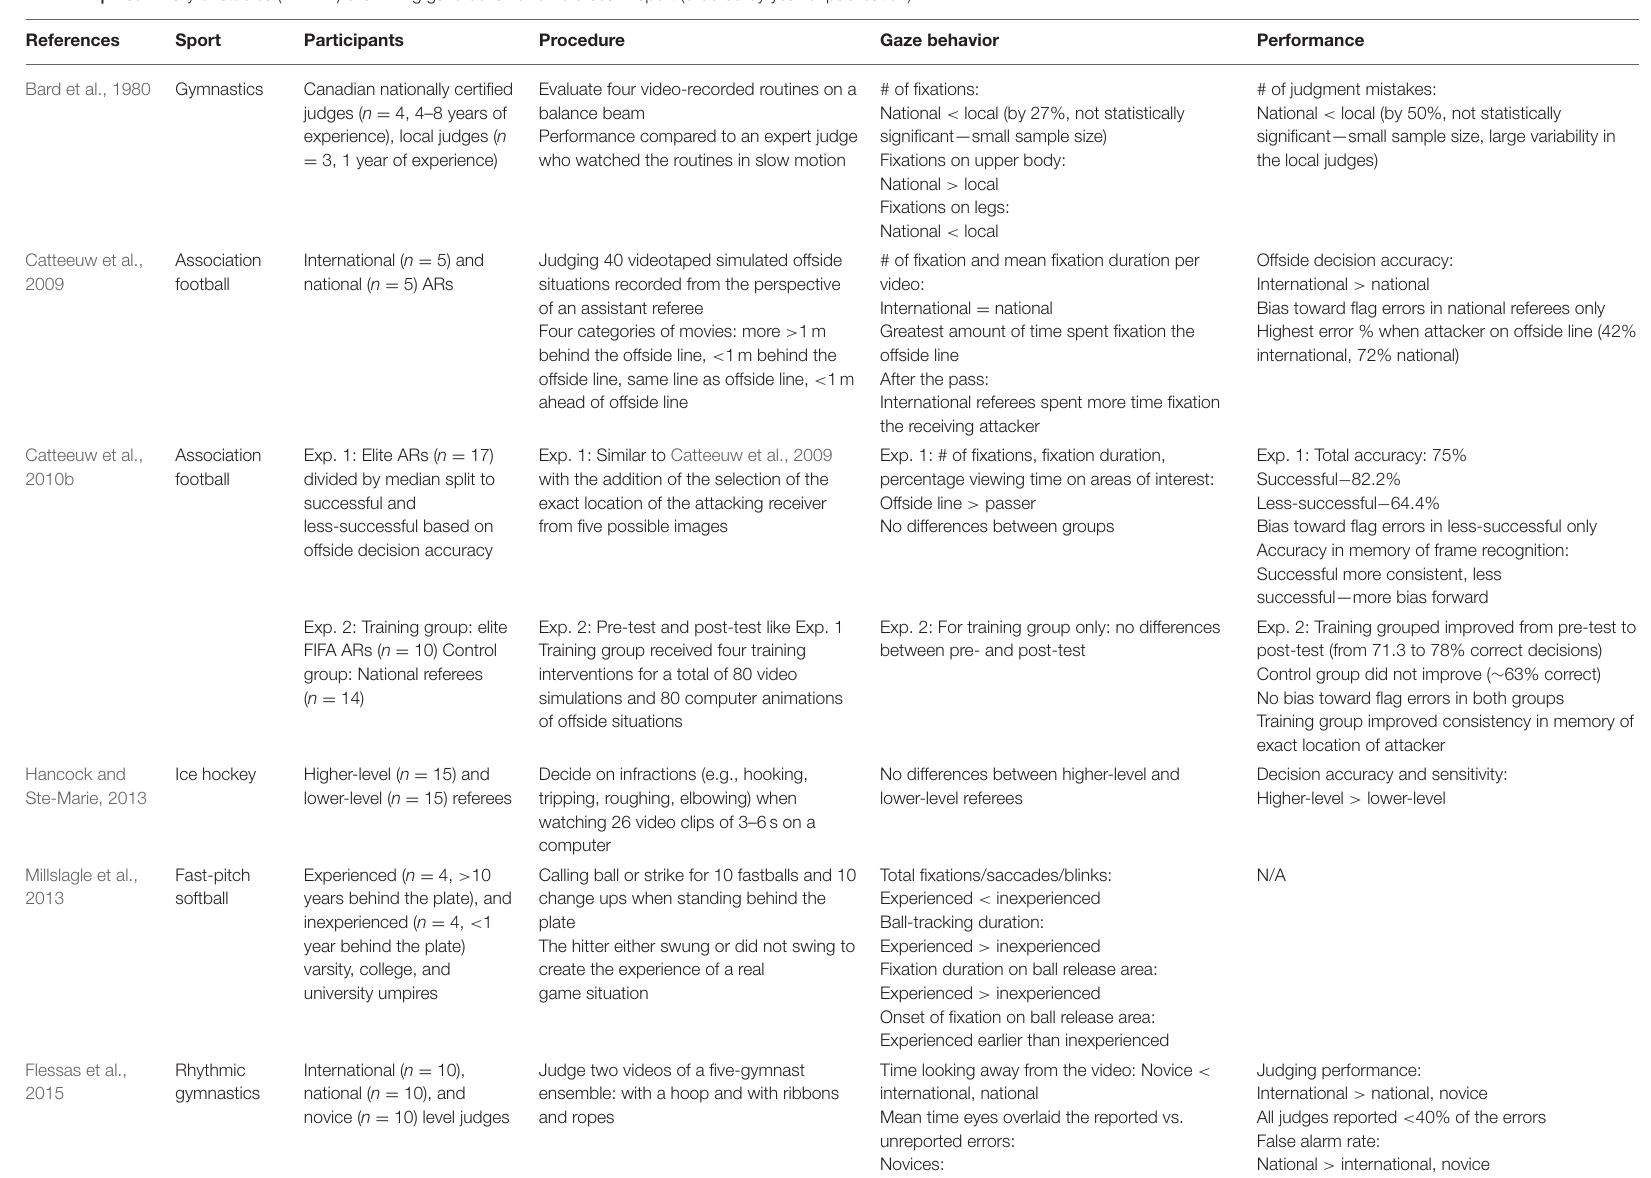
TABLE 2 | A summary of studies ( N = 12) examining gaze behavior of referees in sport (ordered by year of